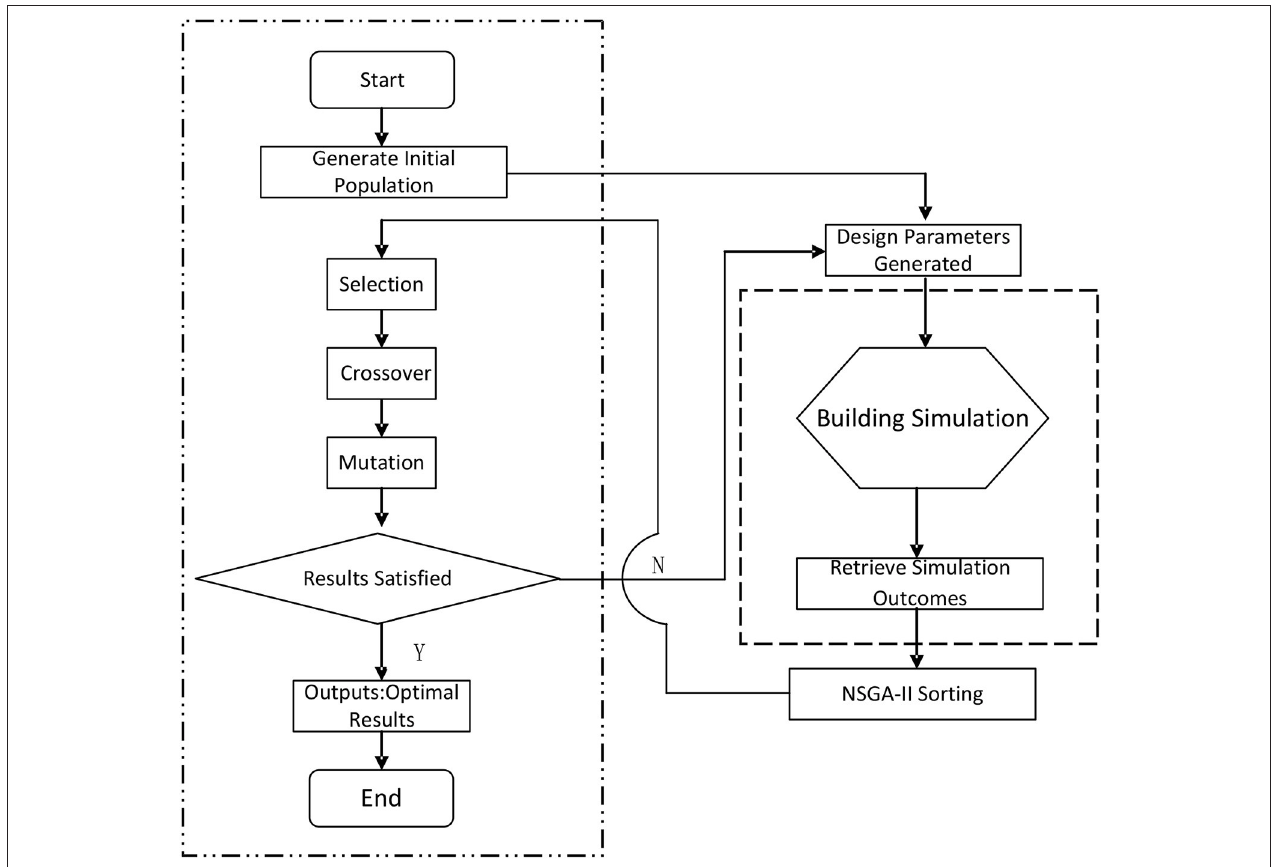
FIGURE 1 | Building design optimization flow diagram.